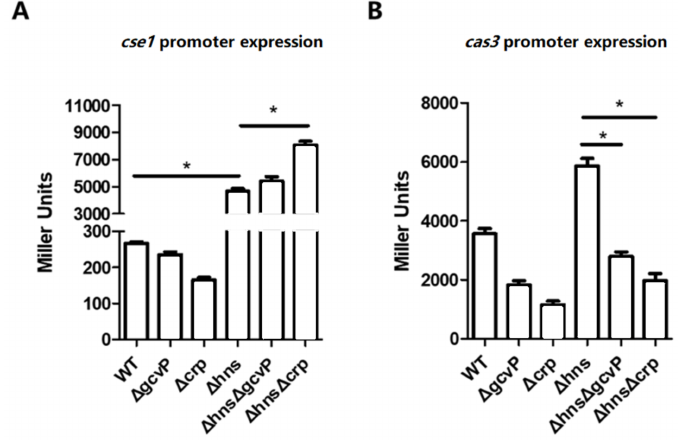
Figure 9. The activation of cse1 by H-NS has no e ff ect on the regulation of cas3 by GCS and CRP. ( A ) The β -gal activity of the cse1 promoter was measured by reporter plasmids (pRCL4) in WT (EC14), ∆ gcvP (EC24), ∆ crp (EC64), ∆ hns (EC94), ∆ hns ∆ gcvP (EC104), and ∆ hns ∆ crp (EC114) cultured in LB. The absence of hns led to a 20 times increase in cse1 expression, and with hns mutation, the deletion of gcvP had no e ff ect on cse1 expression, and the deletion of crp led to slight increase in cse1 expression. ( B ) The β -gal activity of the cas3 promoter was measured by reporter plasmids in WT, ∆ gcvP , ∆ crp , ∆ hns (EC91), ∆ hns ∆ gcvP (EC101), and ∆ hns ∆ crp (EC111) cultured in LB. In the ∆ hns , cas3 promoter activity was slightly increased compared to WT. The expression levels of cas3 in ∆ hns ∆ gcvP (EC100) and ∆ hns ∆ crp (EC110) were significantly lower than that in ∆ hns . All the data were mean ± SEM of at least three replicates, and the p value (* p < 0.05) was analyzed by the t